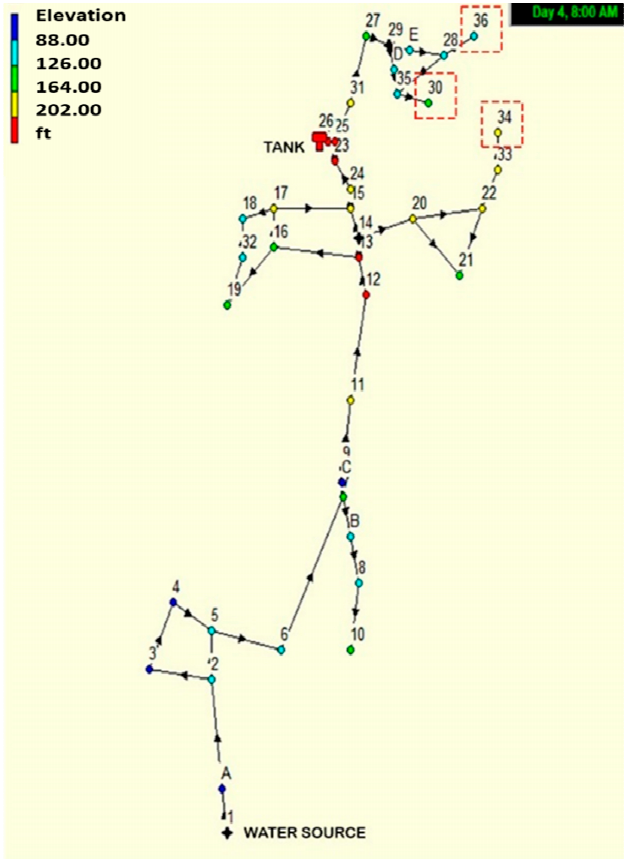
Figure 1. WDN Net Example 2 by Boccelli and adapted from EPANET. Where arrows represent the water flow direction. Red dashed squares remark the nodes analyzed later.